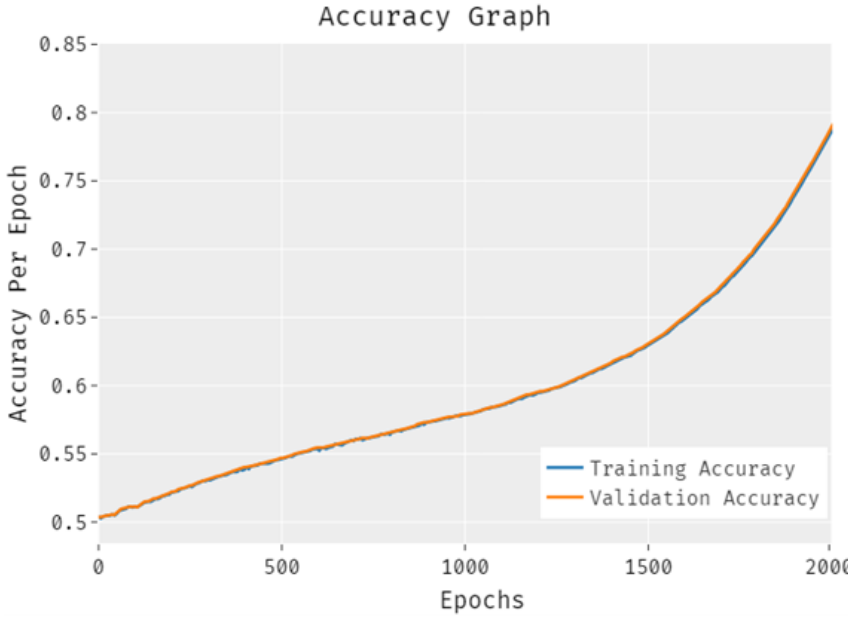
Figure 9. Accuracy analysis of ESOML-IDS technique under 2000 epochs.